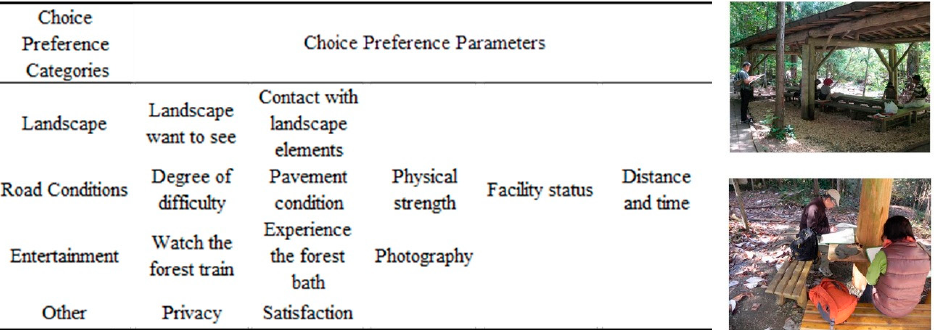
Figure 2. Classification of tourist preferences and the study site.